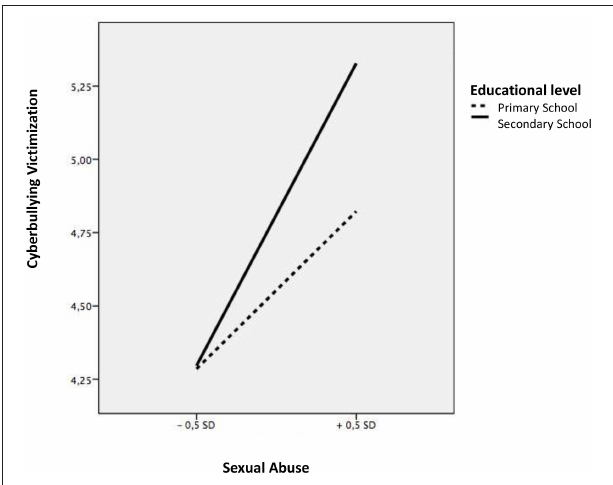
FIGURE 5 | Interaction between sexual abuse and educational level in relation to cyberbullying